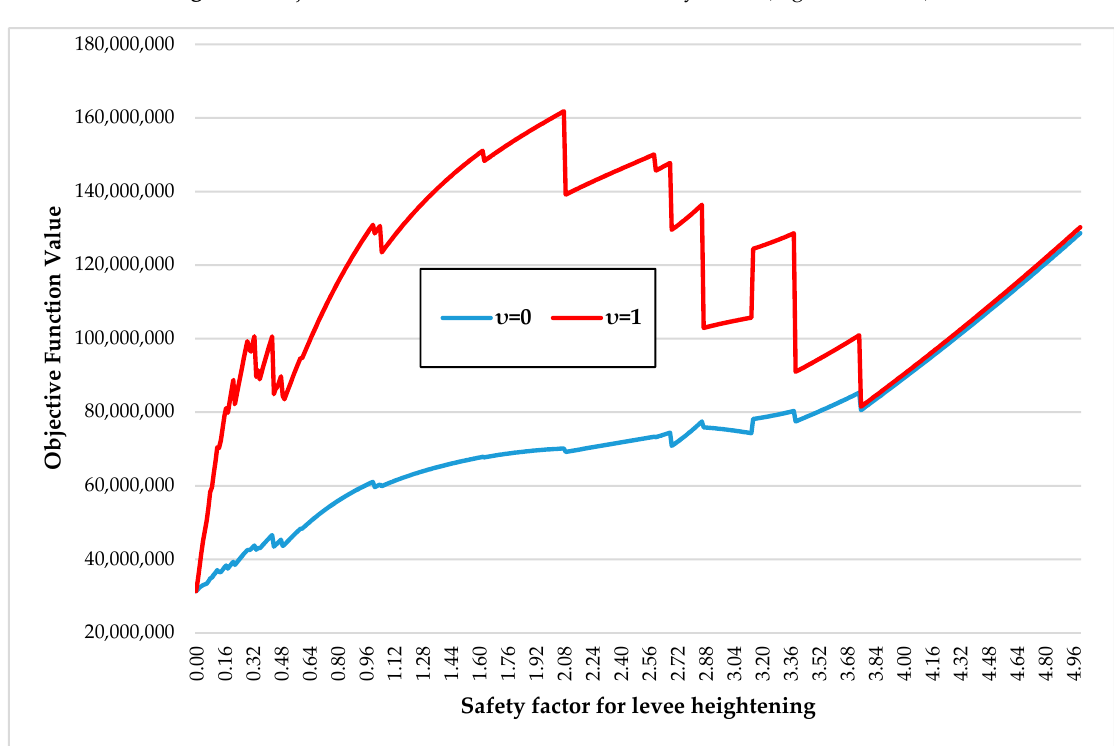
Figure 4. Objective function variation with the safety factor (low value case).